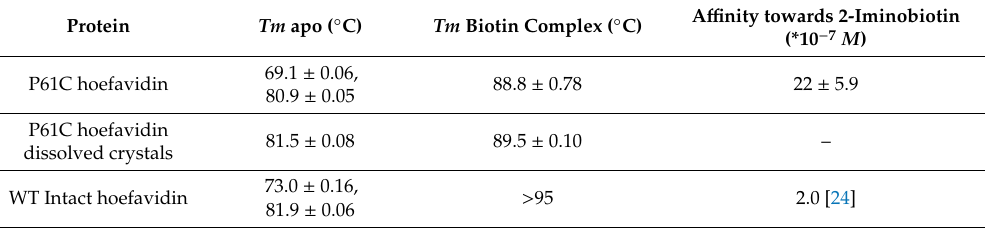
Table 2. Thermostability and a ffi nity towards 2-iminobiotin.